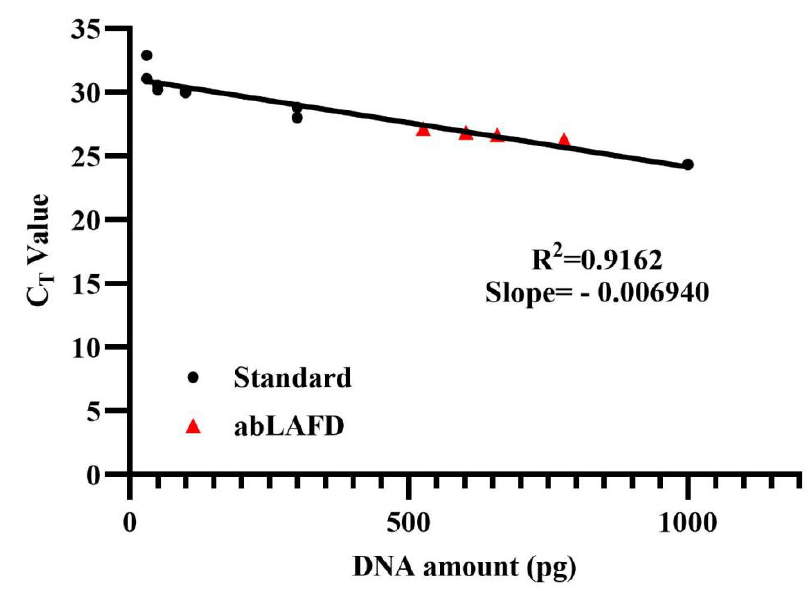
Figure 3. The calibration curve obtained from amplifications of control DNA samples. A dilution series of 9947A (1 ng, 300 pg, 100 pg, 50 pg and 30 pg) were prepared and tested in duplicate as standard samples to generate a calibration curve. The abLAFD reaction was prepared in duplicates and then the abLAFD products from each tube was quantified twice. Standard samples are denoted in black dots and the four abLAFD product samples are denoted in red triangles.